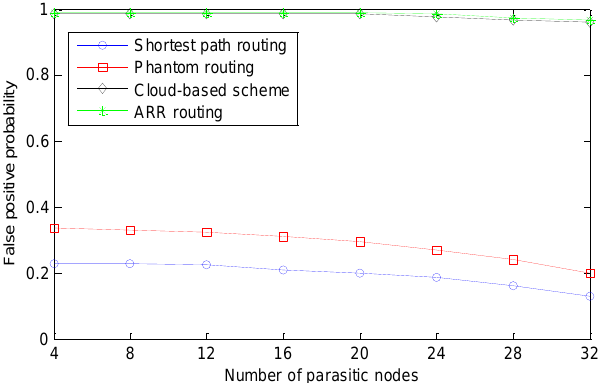
Figure 11. Source detection false positive probability with different numbers of parasitic nodes.